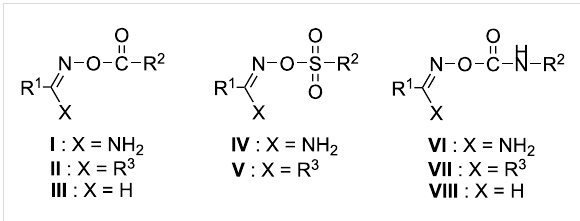
Figure 1: General structures of oxime derivatives with possible DNA photocleavage ability. Left: Oxime carboxylates: O -acyl amidoximes ( I ), O -acyl ketoximes ( II ), O -acyl aldoximes ( III ). Centre: Oxime sulfonates: O -sulfonyl amidoximes ( IV ), O -sulfonyl ketoximes ( V ). Right: Oxime carbamates: O -carbamoyl amidoximes ( VI ), O -carbamoyl ketoximes ( VII ) and O -carbamoyl aldoximes ( VIII ).